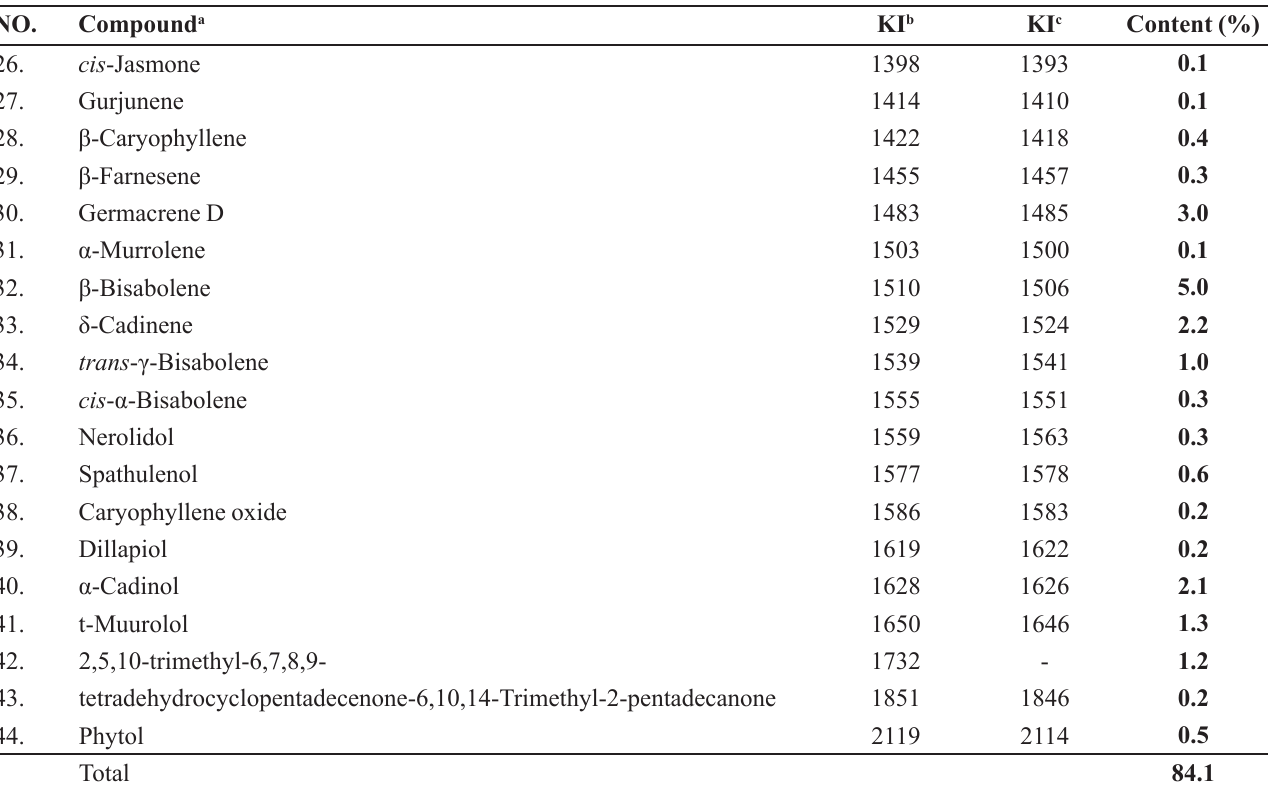
TABLE II - GC-MS analysis of TBEO